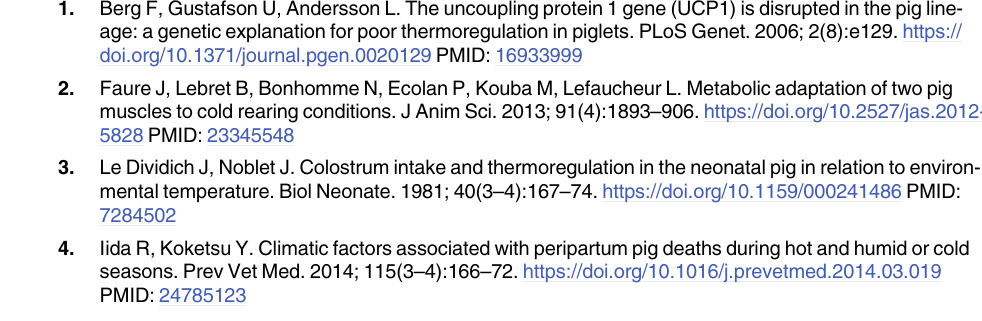
S4 Table. The differentially expressed mRNA between B vs C group. S5 Table. Go analysis of differentially expressed up-regulated genes in A vs C. S6 Table. Go analysis of differentially expressed up-regulated genes in B vs C. S7 Table. Go analysis of differentially expressed down-regulated genes in A vs C. S8 Table. Go analysis of differentially expressed down-regulated genes in B vs C. (XLSX) S9 Table. The differentially expressed lncRNA in A vs C group. S10 Table. The differentially expressed lncRNA in B vs C group. S11 Table. Top 10 upregulated and downregulated lncRNAs in chronic low-temperature acclimation group. S12 Table. Top 10 upregulated and downregulated lncRNAs in acute short cold stress